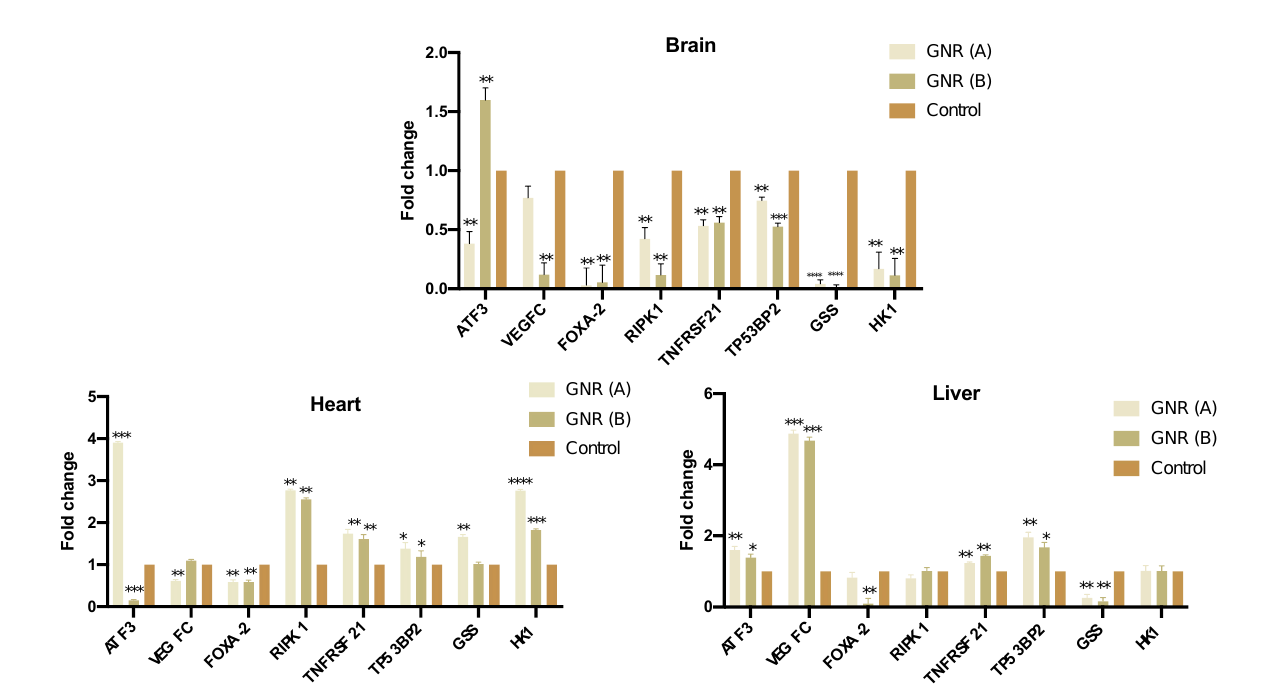
Figure 4. RT-PCR analysis of genes implicated in apoptosis, angiogenesis, and cellular energy metabolism using the brain, heart, and liver tissues of chicken embryos treated with GNR (A) or (B) compared to the control. Data are represented as mean ± standard deviation (SD), * p < 0.05, ** p < 0.01, *** p < 0.001, **** p < 0.0001.